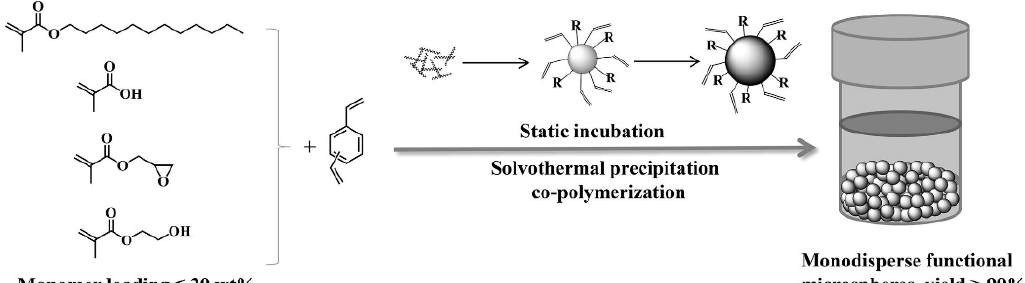
Figure 5. The synthetic scheme of the micro-sized monodisperse poly(methacrylic monomer- divinylbenzene) microspheres fabricated by solvothermal precipitation co-polymerization. Reprinted with permission from Ref. [92]. Copyright 2021 Elsevier B.V.